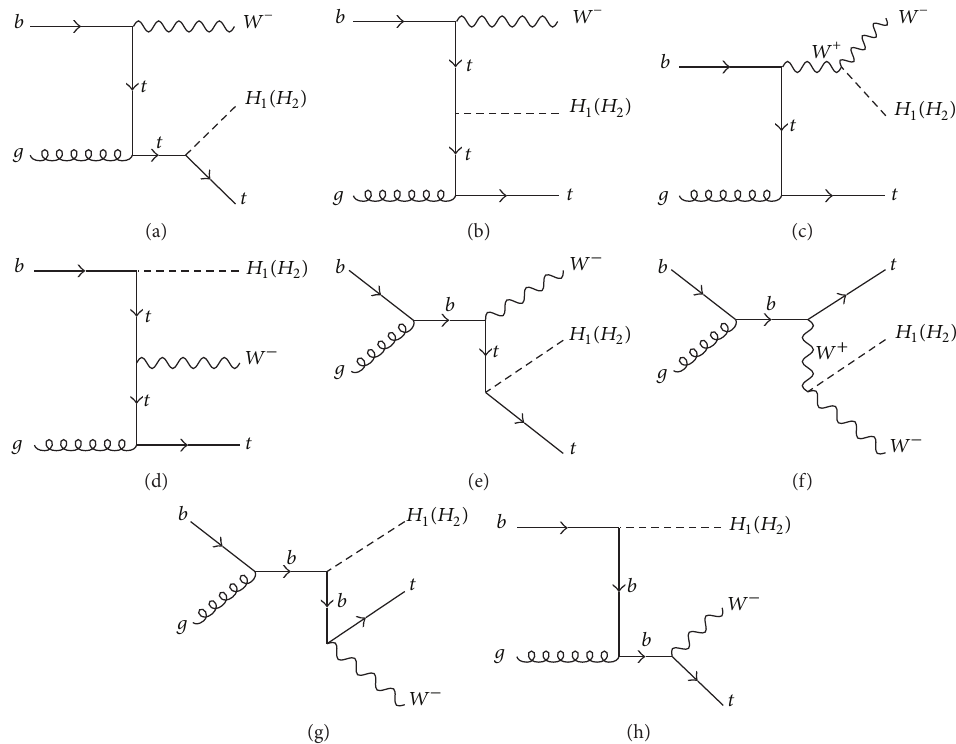
Figure 3: Lowest-order Feynman diagrams for 𝑝𝑝 → 𝑡𝐻 1 (𝐻 2 )𝑊 − in the 𝑈(1) 𝐵